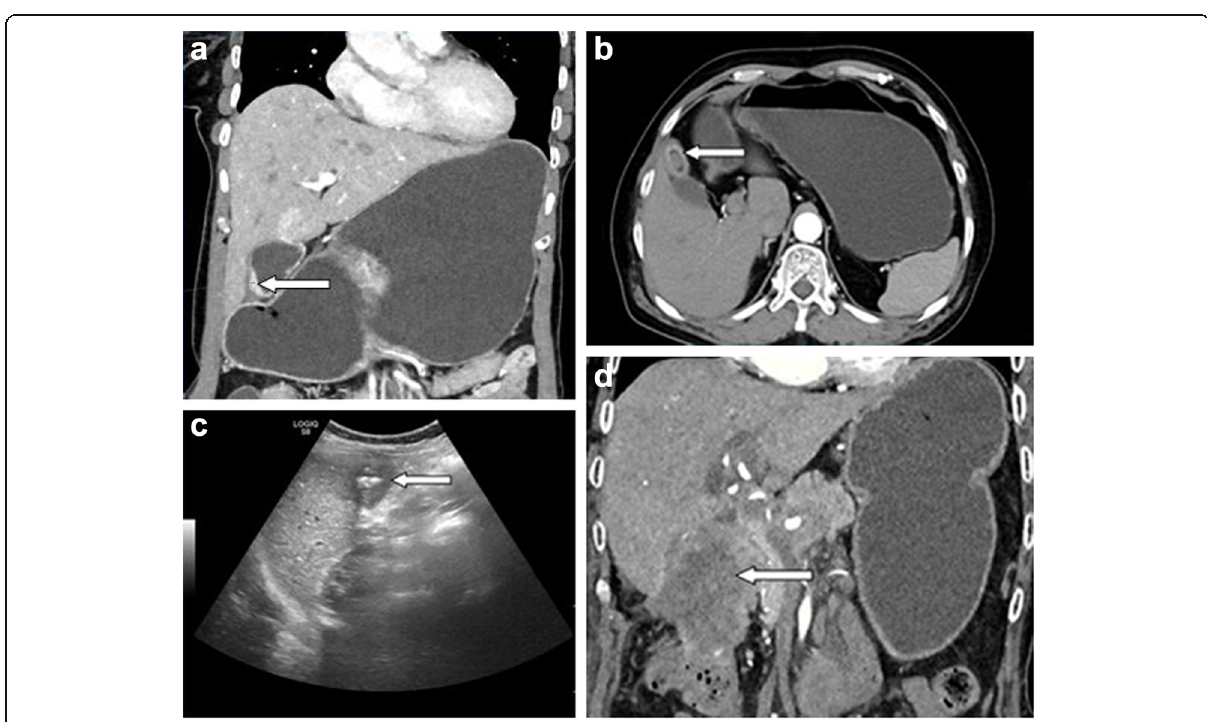
Fig. 2 Different forms of presentation of gall bladder carcinoma ( a - d